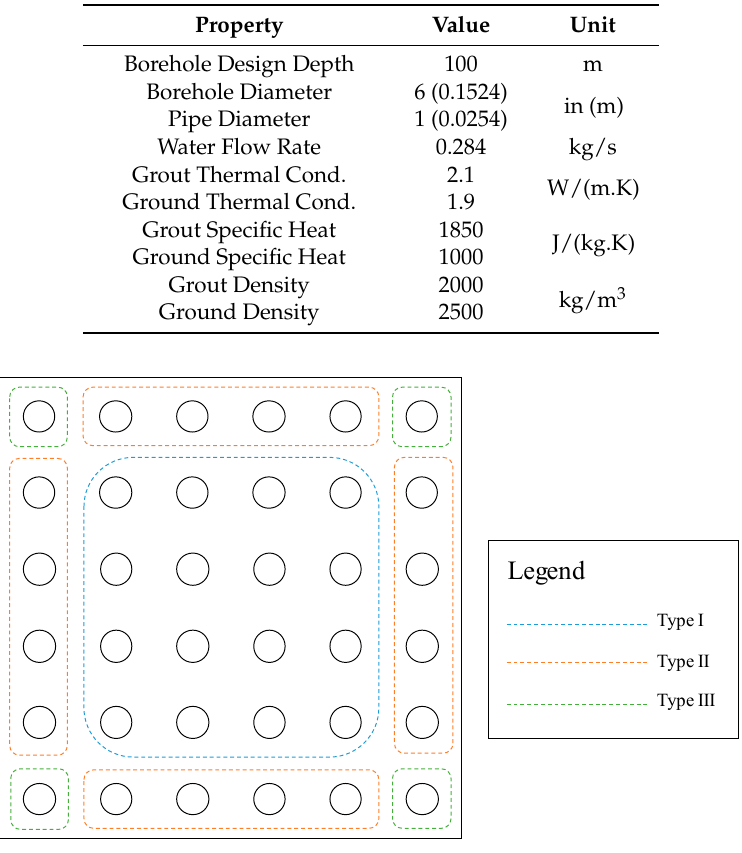
Table 3. Borehole design parameters.